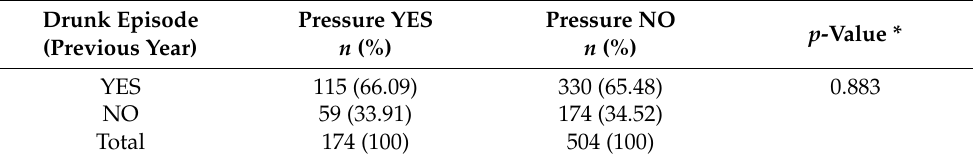
Table 1. Drunk episodes and pressures to consume alcohol ( n =